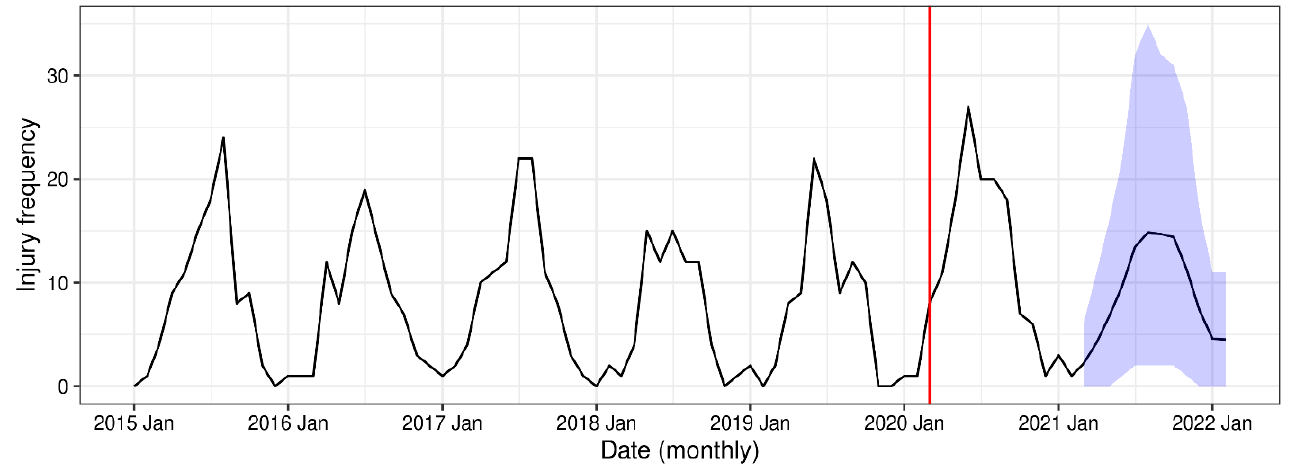
Figure 3. Monthly frequency of pediatric bicycle injuries between 1 January 2015 and 30 March 2022. Start of COVID-19 pandemic on 1 March 2020 is shown with the red line. Blue shaded area is 90% prediction interval for pediatric bicycle injury, assuming the pandemic effect had decayed to zero, from 1 March 2021 to 28 February